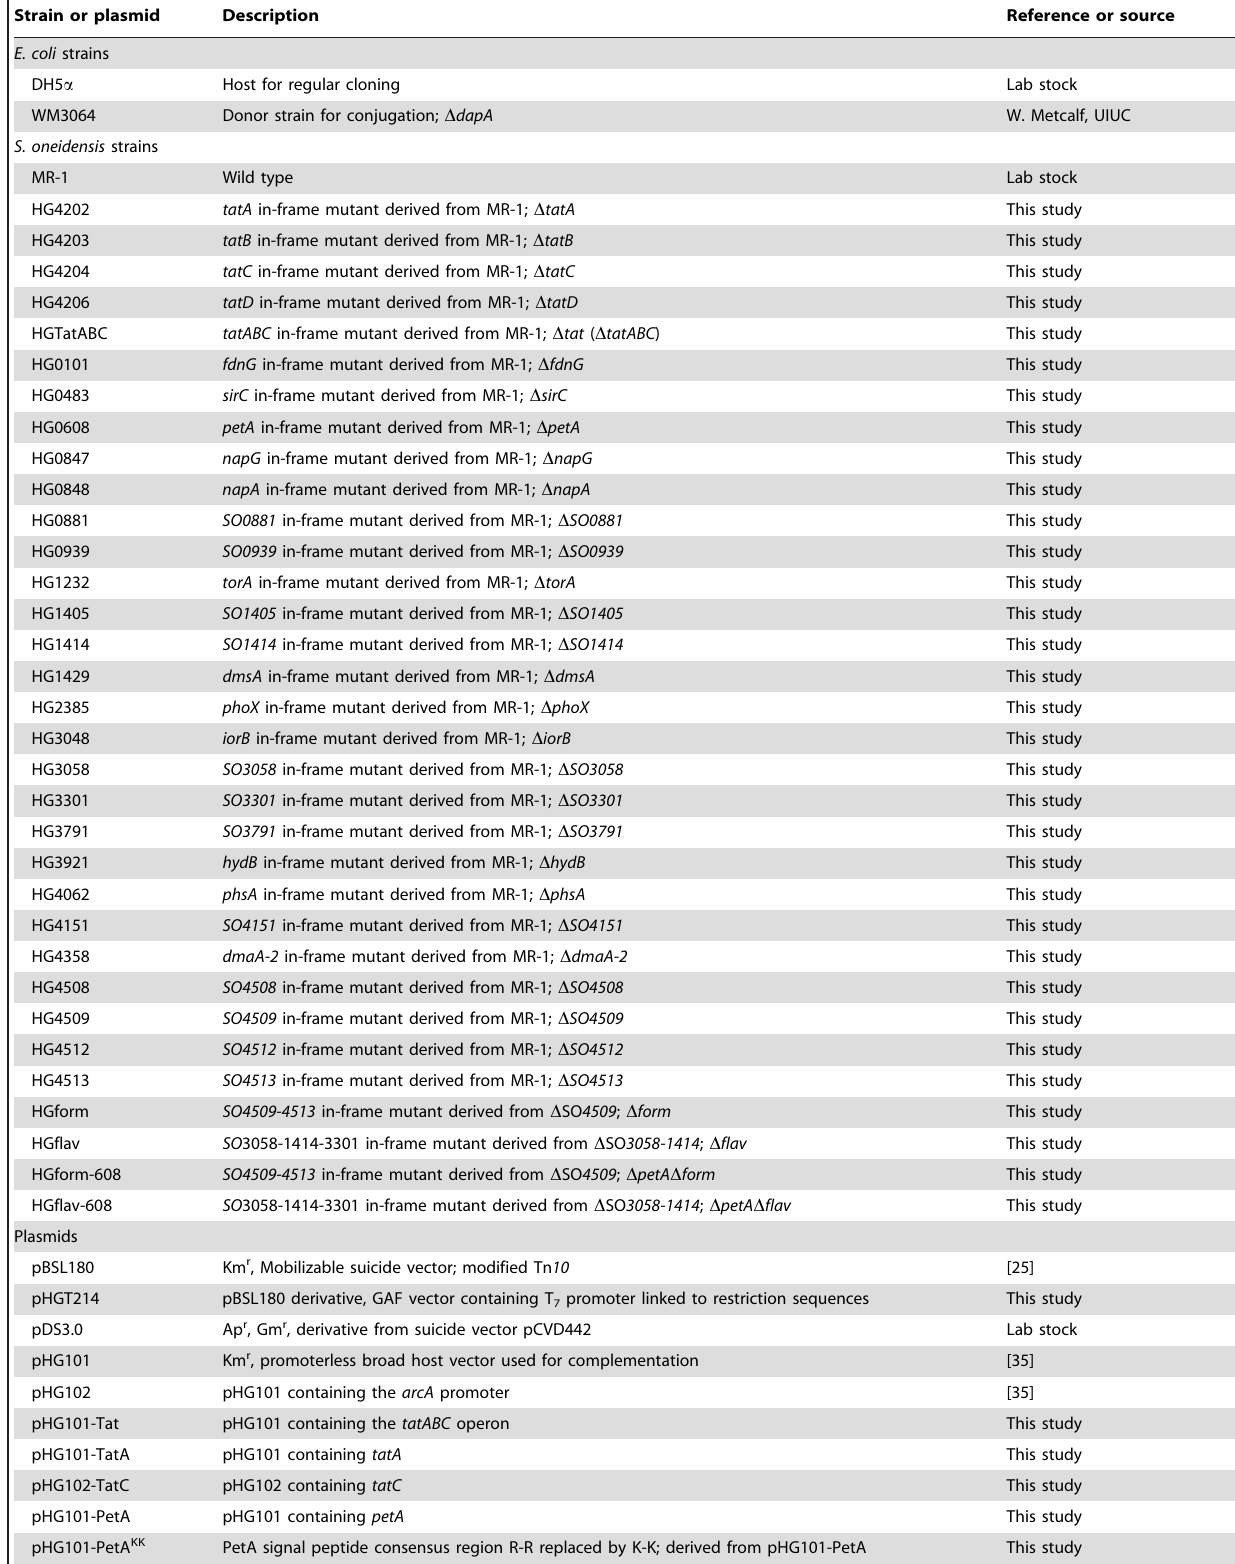
Strain or plasmid